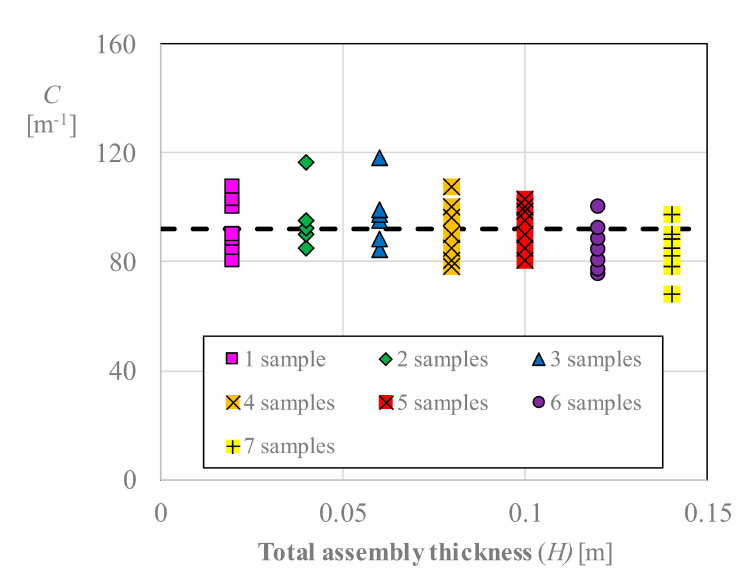
Figure 5. Inertia coe ffi cient ( C ) values obtained for AL-10-96 as a function of the assembly thickness (n ◦ of samples).